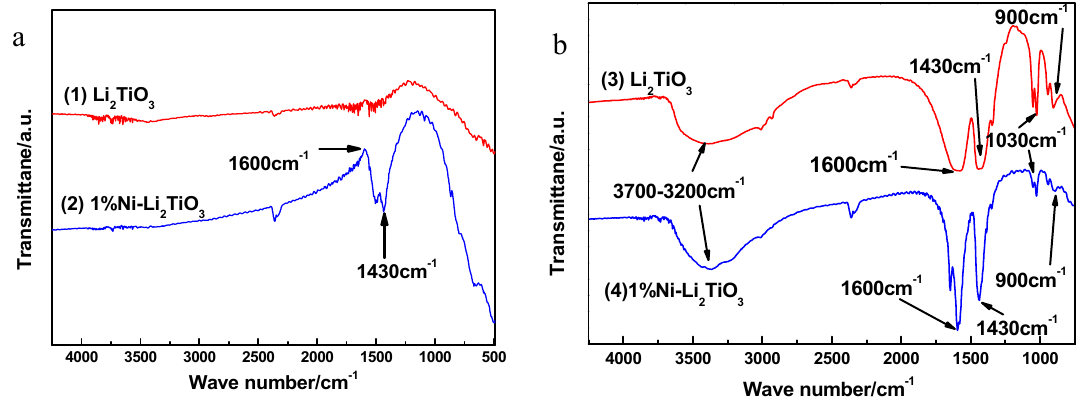
Figure 8. Infrared spectra for Li 2 TiO 3 prepared under different conditions. ( a ) After calcination; ( b ) Before calcination.